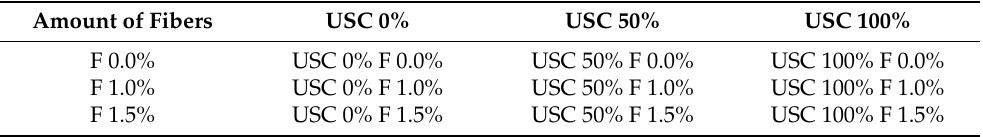
Table 3. Marking of nine groups of examined